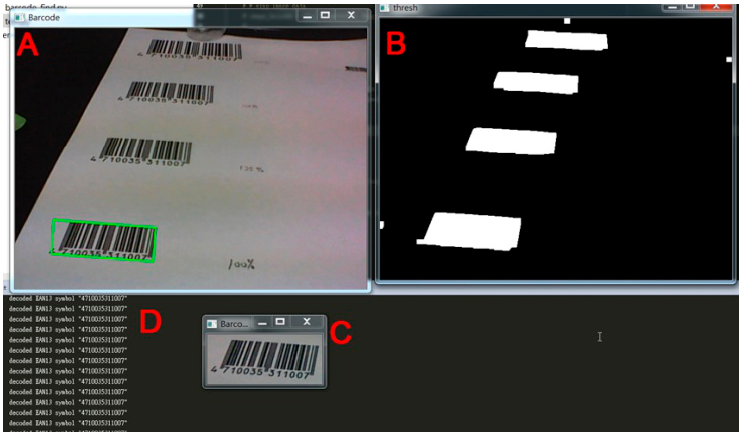
Figure 11. The experimental results of barcode identification with four parts including: ( A ) An original image; ( B ) A binary image; ( C ) A region of interest; and ( D ) Digital contents of the barcodes.